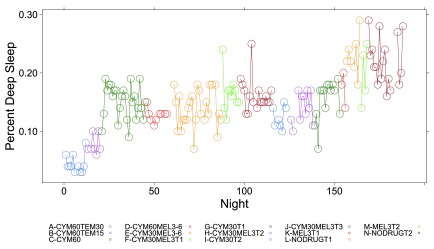
Percent deep sleep per night.The percent time subject was in deep sleep during 5-minute intervals detected by the Zeo Sleep Monitor throughout the entire study. Dosages of Cymbalta (CYM60 = 60 mg, CYM30 = 30 mg), temazepam (TEM30 = 30 mg, TEM15 = 15 mg) and melatonin (MEL3 = 3 mg, MEL6 = 6 mg) were varied according to combinations A–N (T1, T2, T3 are trial replicates), including no drug trials (L, N).